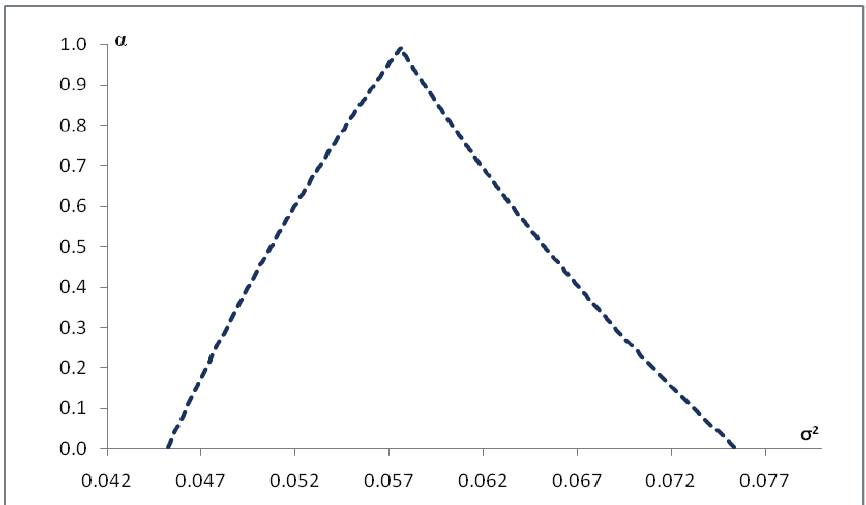
Figure 2 Membership function of process variance for